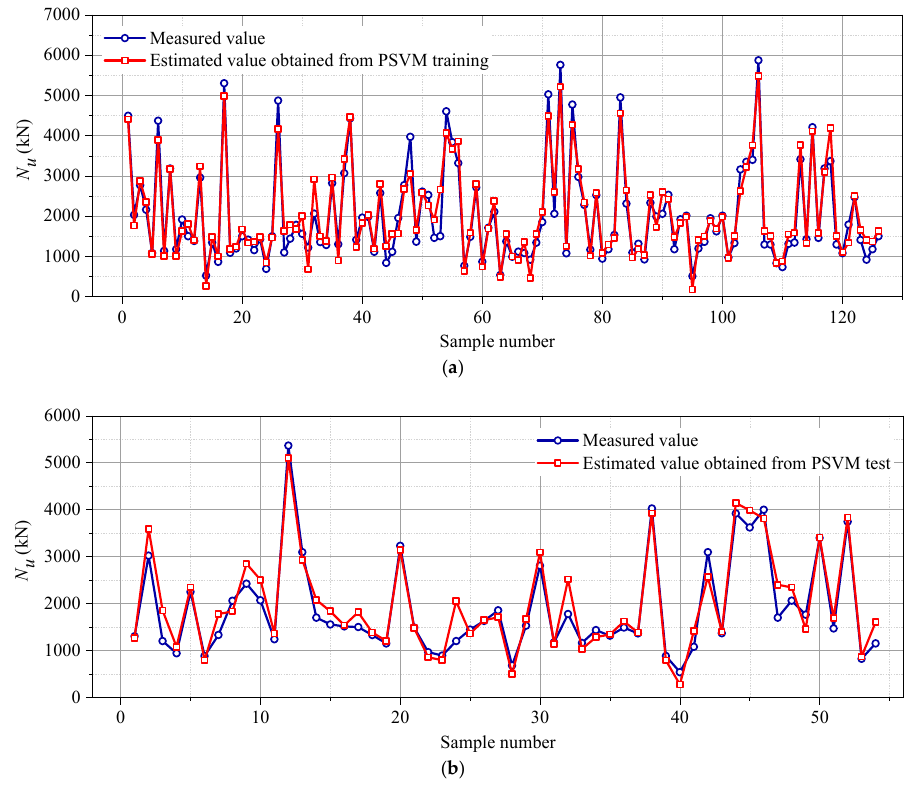
Figure 5. Measured and estimated N u values obtained from PSVM in the ( a ) training set and ( b ) test set.